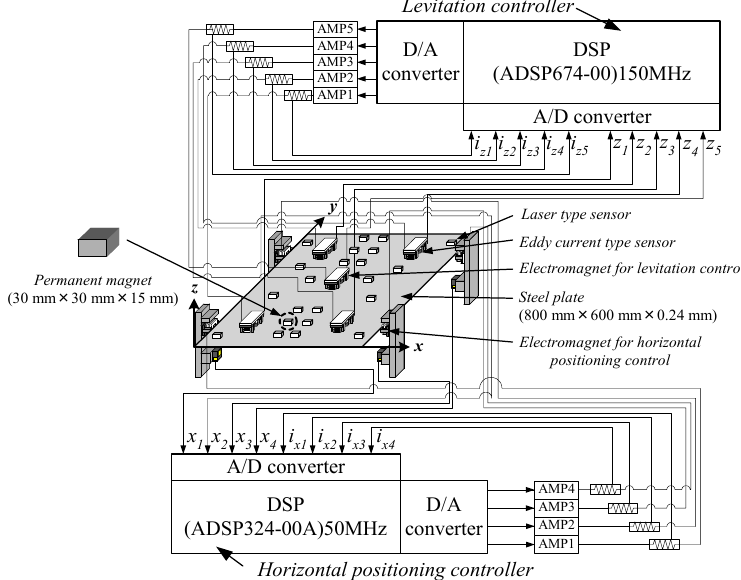
Figure 1. Hybrid electromagnetic levitation system integrating positioning control in the horizontal direction.